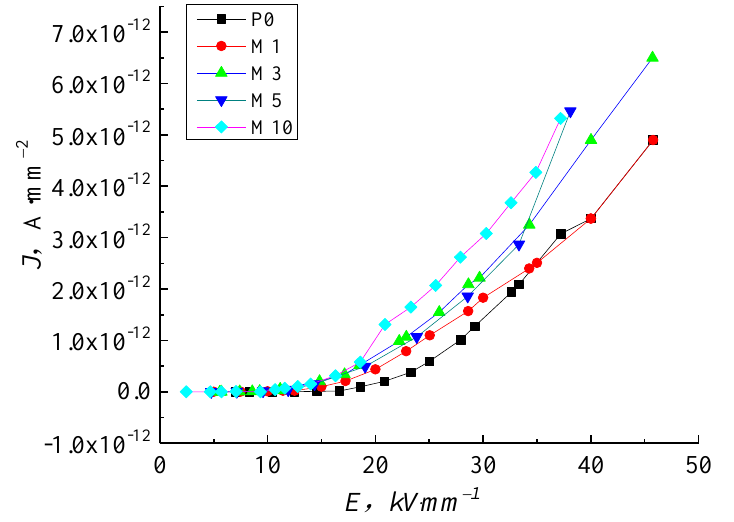
Figure 6. J-E characteristic curve of LDPE and micro-ZnO/LDPE with different content.